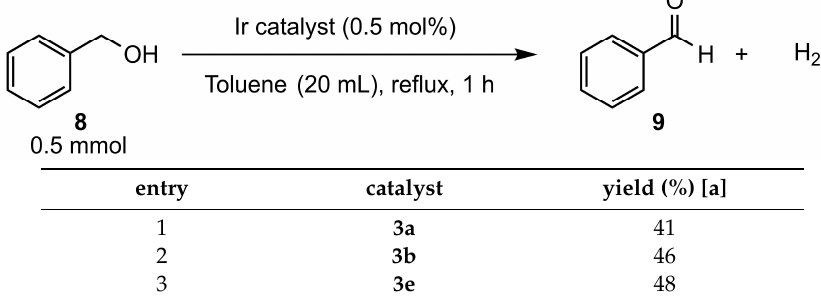
Table 3. Catalytic activity of iridium complexes 3a , 3b , and 3e in the dehydrogenation of 8 .